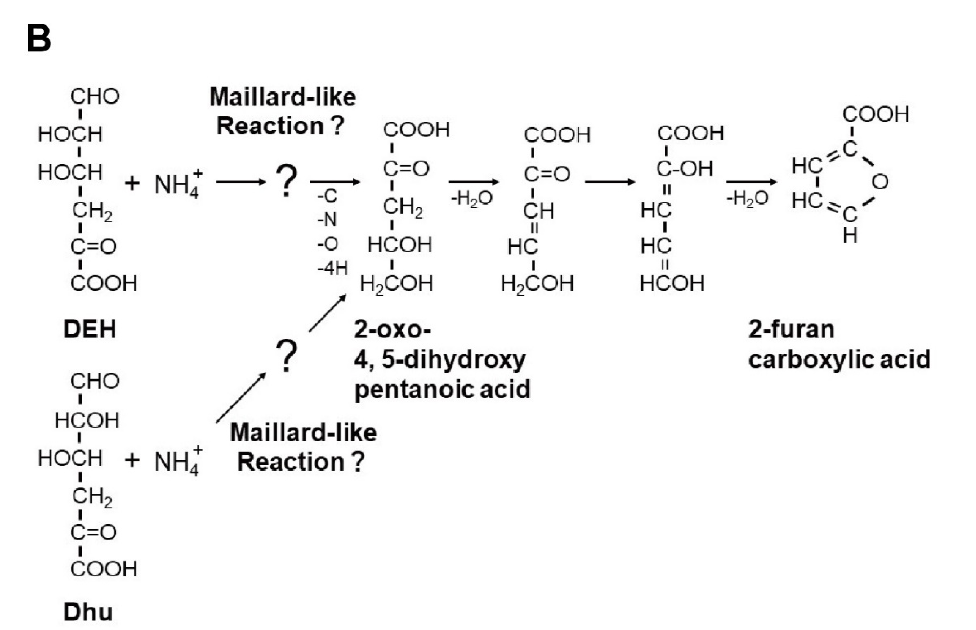
Figure 3. Reactions of DEH. ( A ) Reactivity of DEH with ammonium salts and amino acids. DEH (1% w / v , 56.8 mM) was incubated with 50 mM amino acids and ammonium salts at 30 °C for 24 h, with the exception of Tyr, Trp, and Asp, which were used at 1.0, 20, and 12.5 mM, respectively, because of their insolubility [21]. Figure modified from Figure 2A in ref. [21]. ( B ) Hypothetical pathway for the formation of 2-furancarboxylic acid from NH 4+ and DEH or Dhu. Dhu is formed from a D -glucuronic acid residue via unsaturated glucuronic acid [28]. Figure modified from Figure 5 in ref. [21].